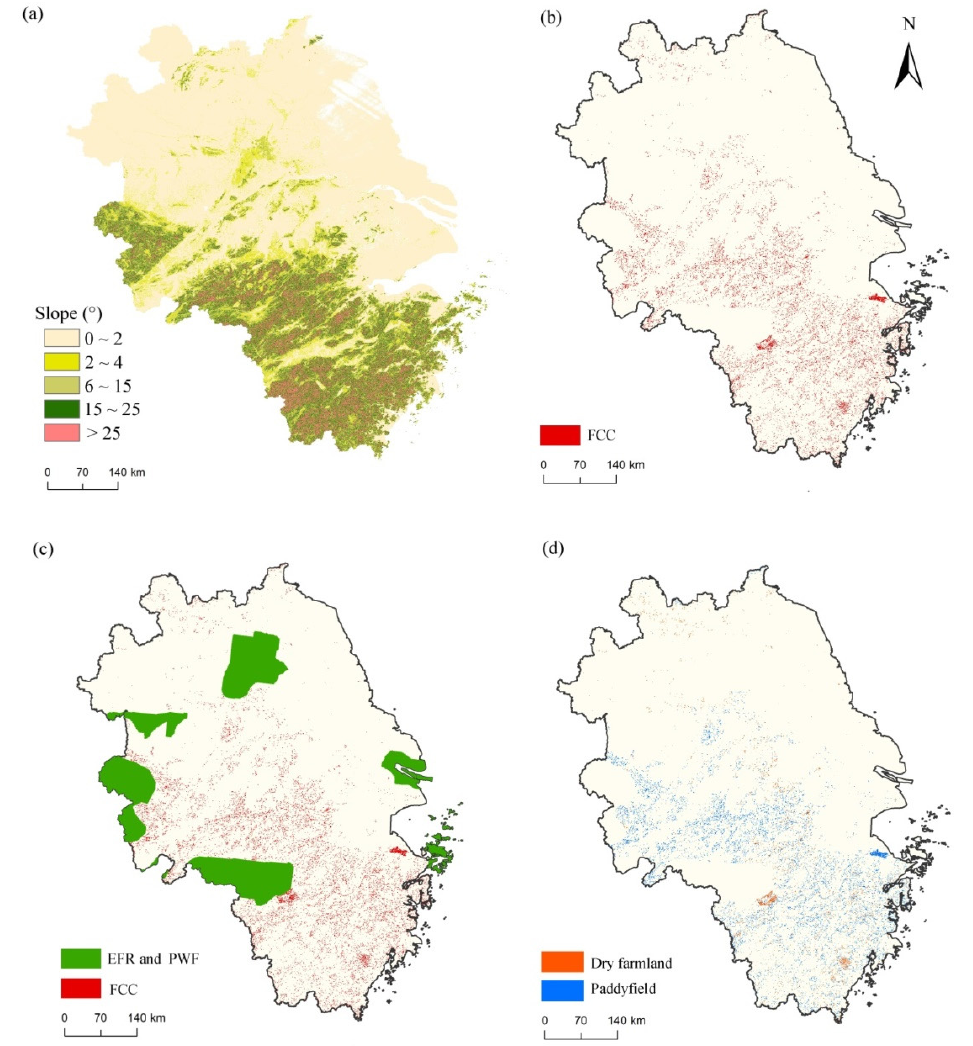
Figure 6. The potential area of forest that can be returned to cultivated land in the Yangtze River Delta region. ( a ) Elevation; ( b ) conversion from cultivated land to forest, which removes forest with slope ≥ 25 ◦ ; ( c ) distributions of ecological function reserves (EFRs) and public-welfare forests (PWFs); ( d ) the final cultivated land (including dry farmland and paddy field) returned from forest after the removal of the forest with slope ≥ 25 ◦ and ecological function reserves and public-welfare forests. FCC is the abbreviation of forest converted from cultivated land. For the instructions of copyright for the base map, see Figure 1.